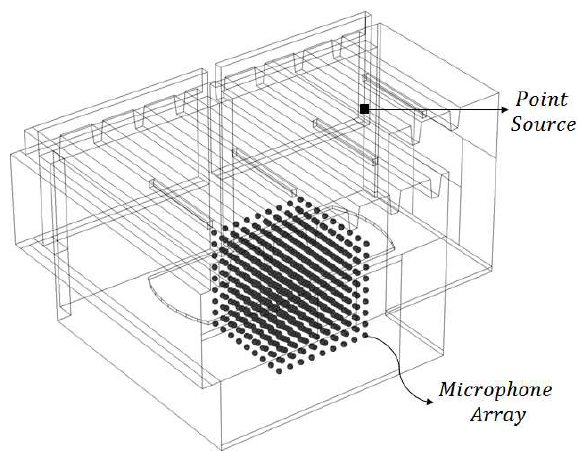
Figure 3. Model of the reference room